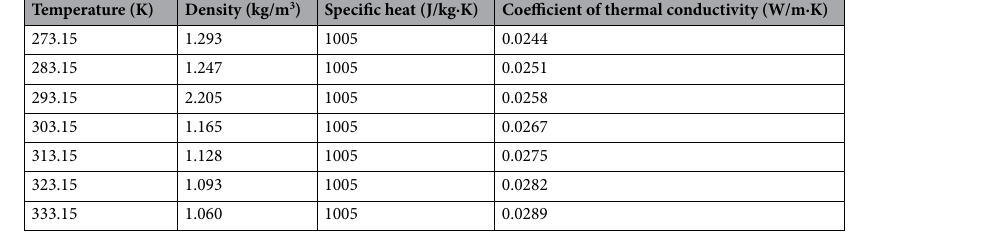
Table 2. Physical parameters of air.